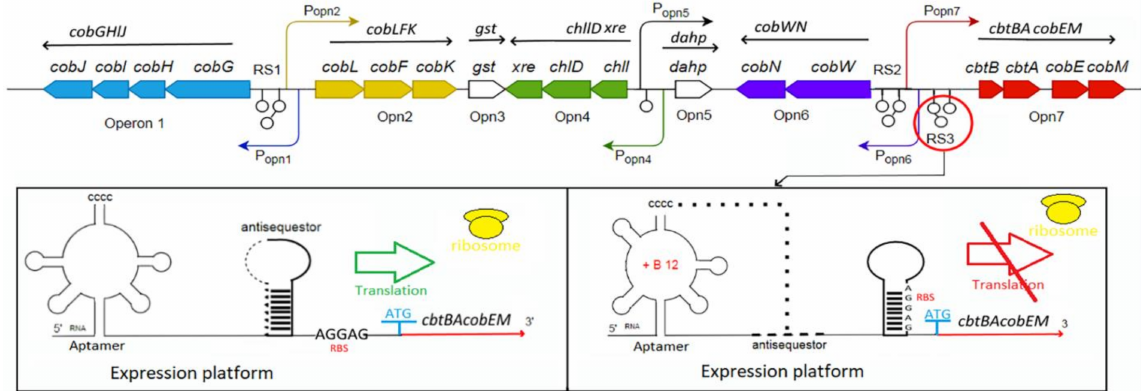
Figure 3. Schematic representation of coenzyme B12 biosynthetic genes cluster I and its riboswitches (RS1, RS2 and RS3) of the P. denitrifians ATCC 13867 genome, according to Nguyen-Vo et al. [26]: biosynthetic genes-thick colored arrows; operons-Operon 1, Opn2, Opn3, Opn4, Opn5, Opn6, Opn7; putative promoters-curved arrows; transcripts-straight black arrows above operons. A coenzyme B12-responsive riboswitch (RS3) structure and schematic mechanism of regulation in mRNA is shown below, according to Zhu et al. [76]: CCCC–P3 aptamer domain forming a pseudoknot under a high concentration of coenzyme B12; antisequestor–sequence complementary to RBS and forming a hairpin to attenuate translation; RBS–ribosome-binding site; ATG–strart-codon; cbtBAcobEM –sequences of the structural genes of the transcript from